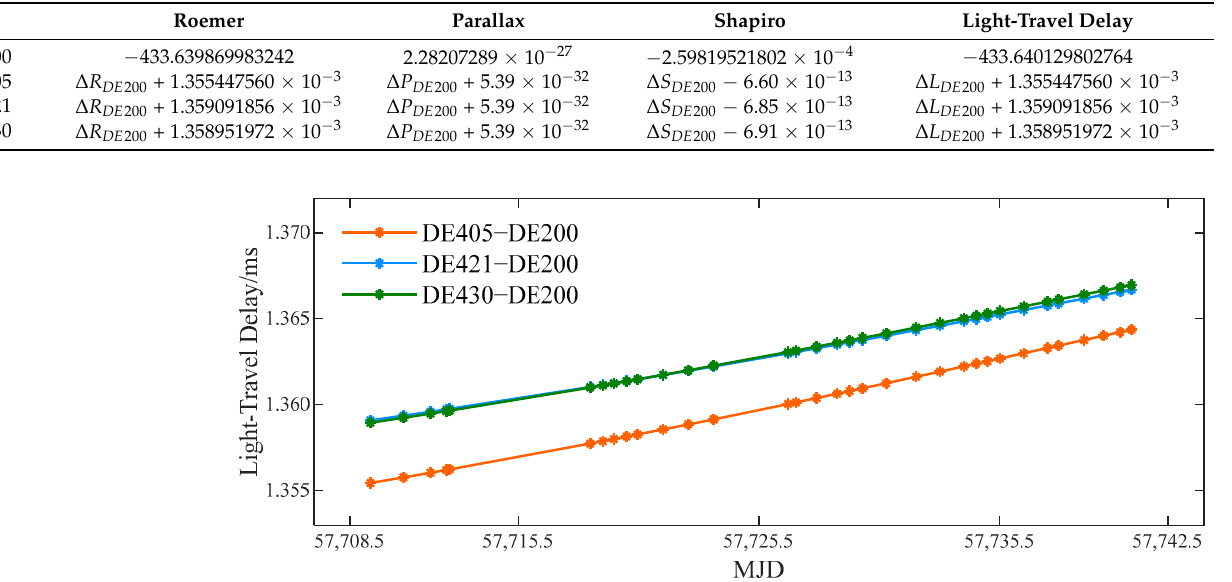
Table 2. Comparison of start time delay of observation data (unit: s, UTC: 2016.11.18 08:00:00.0). Roemer Parallax